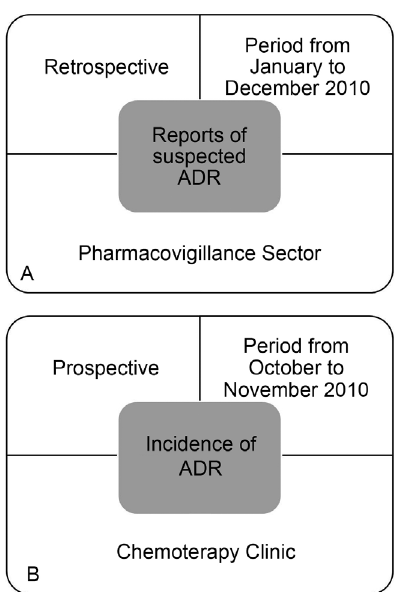
FIGURE 1 - Schematic of the study design. (A) Spontaneous notifications of suspected adverse drug reactions (ADRs) affecting oncology patients and (B) Incidence of adverse drug reactions (ADRs) and degrees of toxicity in the Chemotherapy